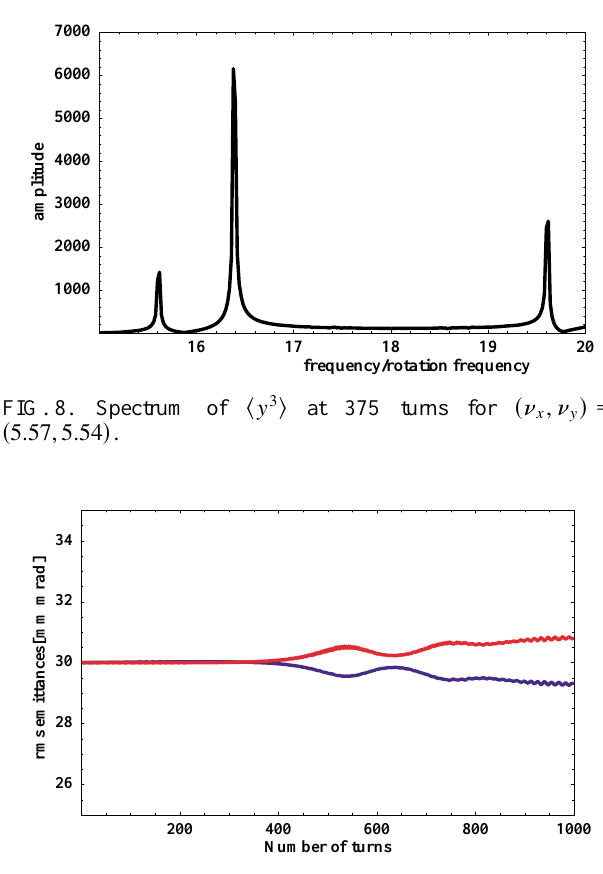
FIG. 9. (Color) Time evolution of rms emittance for (cid:1) n x , n y (cid:2) (cid:1) (cid:1) 5.57, 5.54 (cid:2) . X emittance is shown in blue and Y emittance is shown in red.